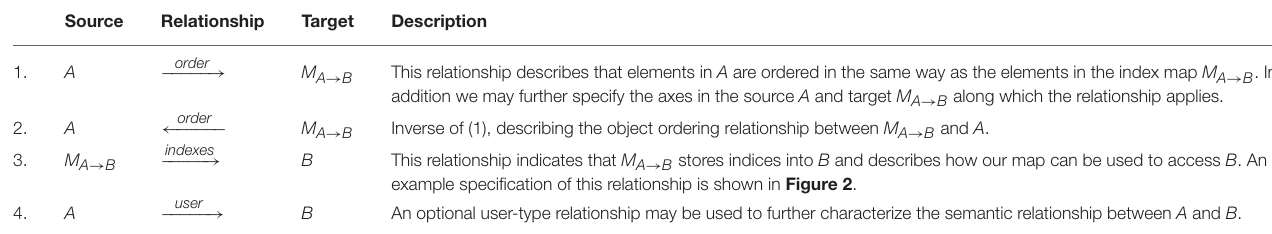
TABLE 1 | Overview of the relationships used to define an advanced index map relationship . Source